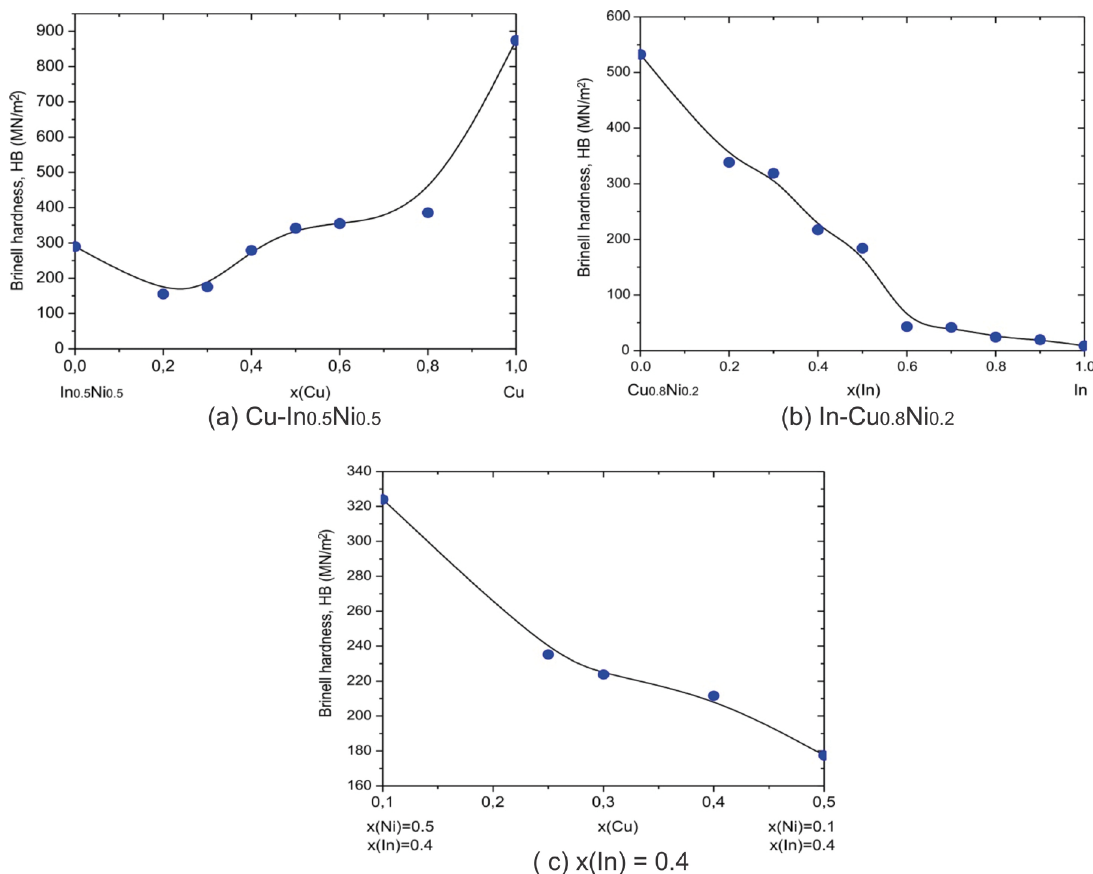
Figure 4. Measured values of Brinell hardness of the alloys from the three studied vertical sections: a) Cu-In c) x(In)=0.4 By using collected experimental results and an appropriate mathematical model it was possible to calculate values of hardness over the whole compositional